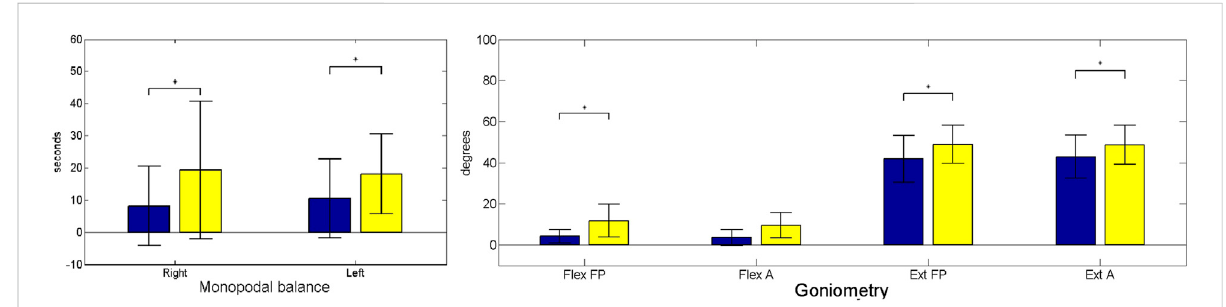
FIGURE 2 Monopodal balance (left sub fi gure) and goniometry (right sub fi gure) mean values. Where A, Active; FP, Forced Passive; Ext, Extension; and Flex, Flexion. Statistically signi fi cant changes are denoted with an asterisk (*). Blue (black if printed in greyscale) corresponds to preintervention; yellow (light grey in greyscale) corresponds to postintervention